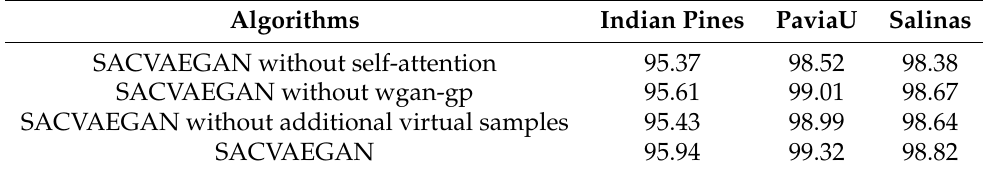
Table 15. OA when self-attention, WGAN-GP, and additional virtual samples are removed. Algorithms